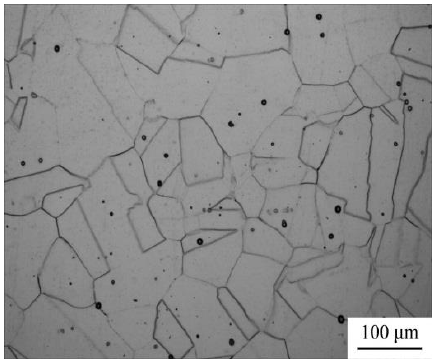
Figure 2. Microstructure of the starting material of Fe-30Mn-0.11C steel for hot compression tests.